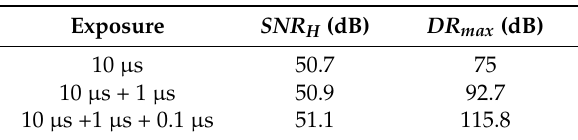
Figure 12. Measured signal, noise and SNR H responses for 3 exposure settings with exposure ratio of 10 and photon threshold K = 2. Table 2. Calculated SNR H and DR max from measured data for the cases of single, double and triple exposures with a ratio of 10 and K =